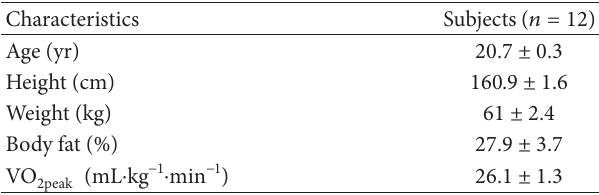
Table 1: Descriptive characteristics of the study subjects.